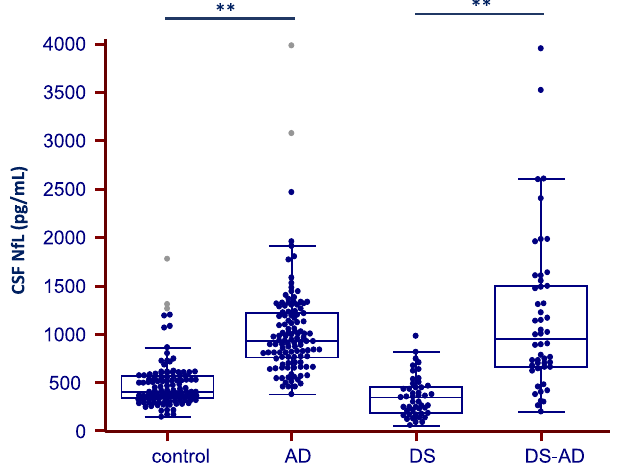
Figure 4. CSF Neurofilament light (NfL) protein levels in patients with Down Syndrome (DS). Box and whisker plots of the median concentrations of CSF NfL in control participants and patients with dementia (Alzheimer Disease, AD) and Down Syndrome associated or not to AD (DS-AD and DS, respectively). The central black lines show the median values, regions above and below these lines show the upper and lower quartiles, respectively. Outliers (indicated with grey circles) are defined as a value that is larger than the upper quartile plus three times the interquartile range. ** p <